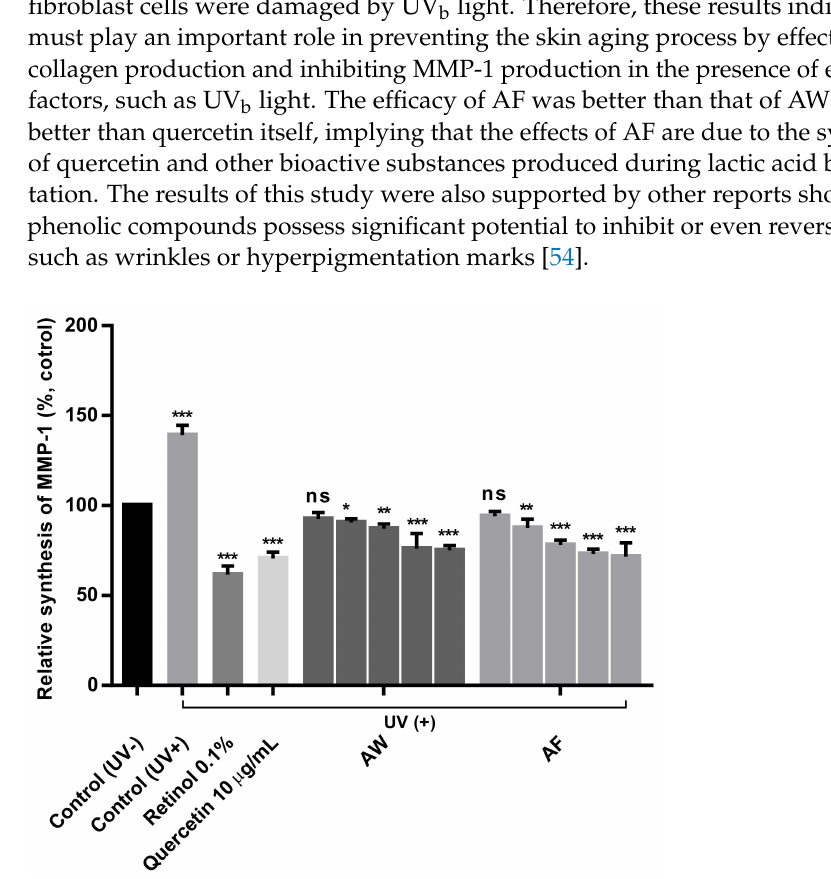
Figure 7. The inhibition of MMP-1 synthesis in UV b -irradiated human skin fibroblasts treated with 10 µ g/mL quercetin and various concentrations of the two different extracts. AW: hot water extraction of Aloe vera leaf skin at 100 ◦ C for 24 h. AF: L. plantarum fermentation of Aloe vera leaf skin at 37 ◦ C for 3 days and extraction with an ultrasonicator at 40 kHz for 1 h at room temperature. The mean values ± SD for separate triplicate experiments are shown, and error bars indicate the SD. The significance of the difference was set to * p < 0.05, ** p < 0.01 and *** p < 0.001 compared with the control